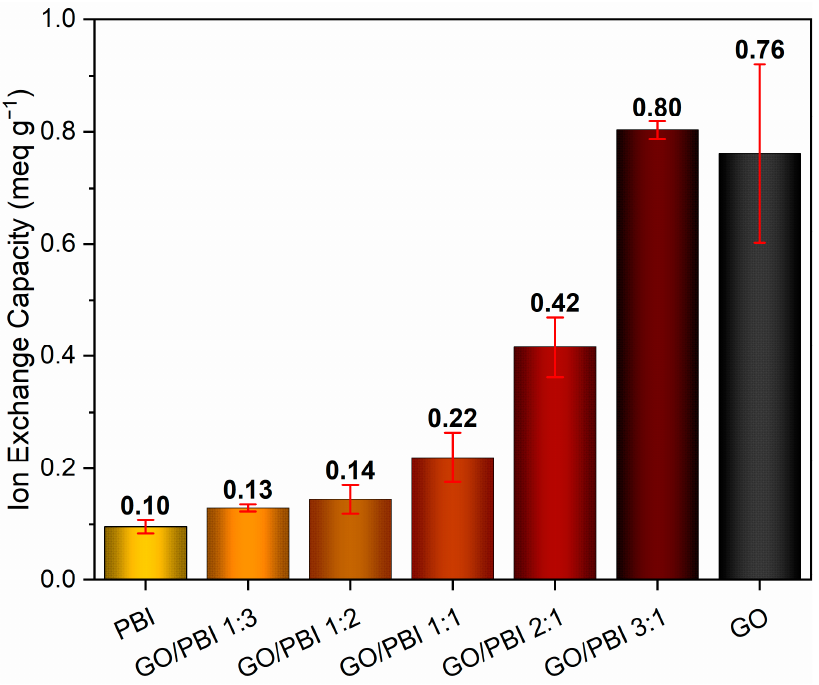
Figure 7. IonexchangecapacityvaluesoftheGO/PBIX:Ycomposites, pureGO,andpurePBI membranes. Figure 7. Ion exchange capacity values of the GO/PBI X:Y composites, pure GO, and pure PBI mem- branes. Table 3. Proton conductivity values of GO/PBI X:Y composites, pure GO, and pure PBI from EIS tests executed at 60, 80, 100, and 120 ◦